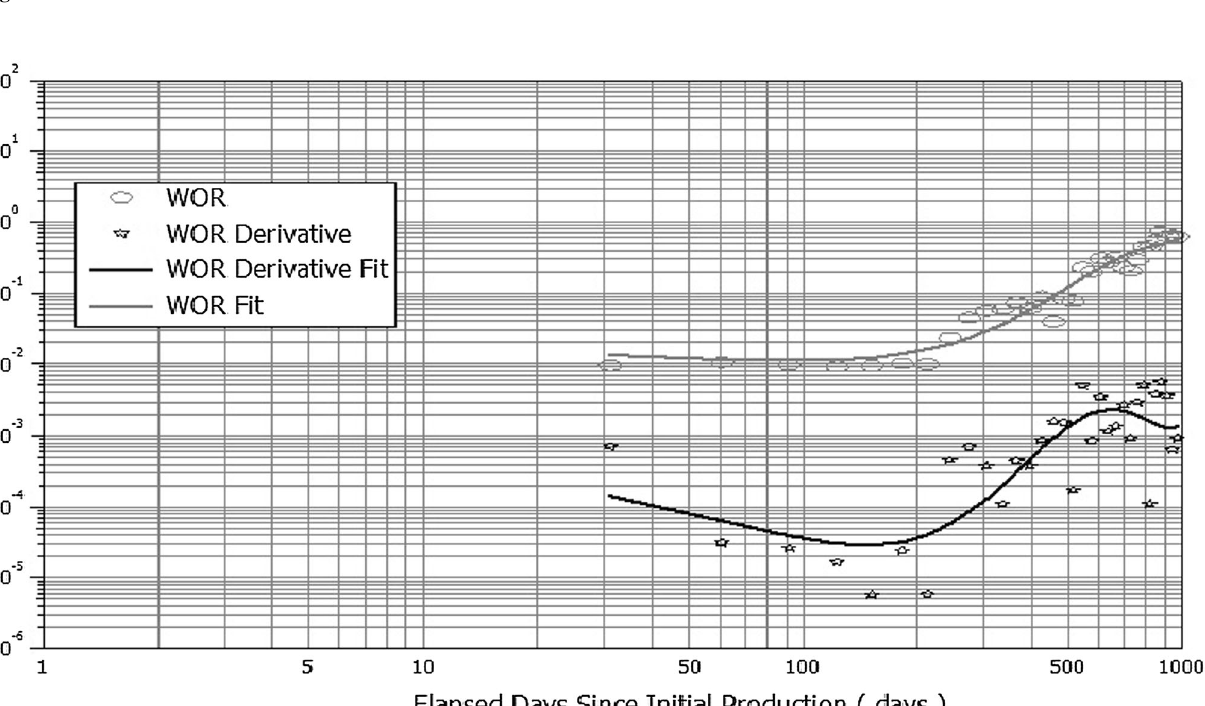
Fig. 2 Production behavior of well-49